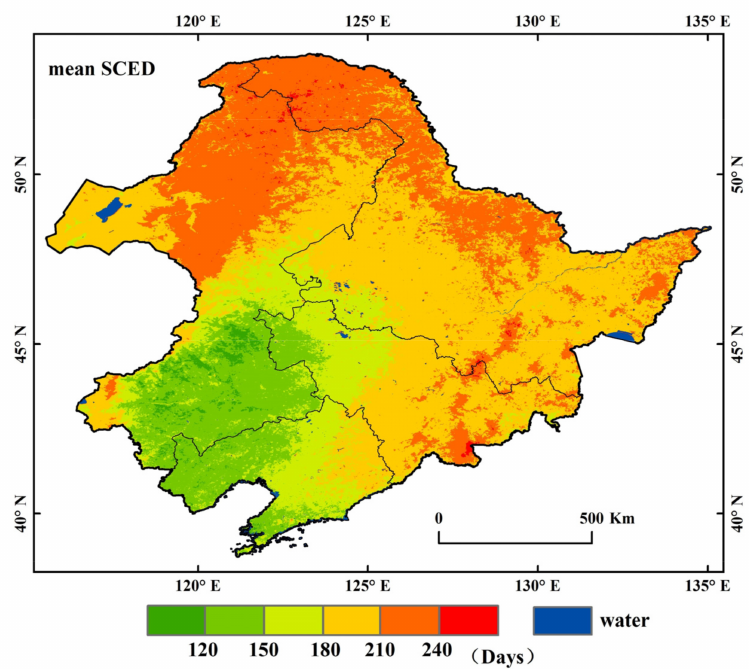
Figure 9. Spatial distribution of annual average SCED in Northeast China from HY2001 to HY2017.